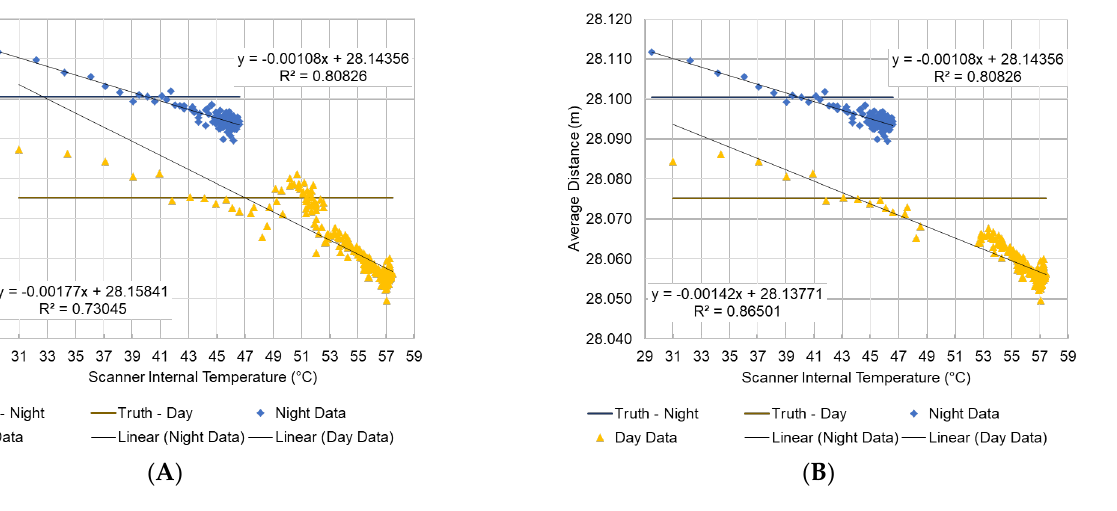
Figure 24. Linear relationship between Velodyne ® HDL–32E average distance measurements and internal temperature for both night and day experiments, ( A ) with and ( B ) without the interference caused by solar radiation, with average truth values plotted for each experiment.